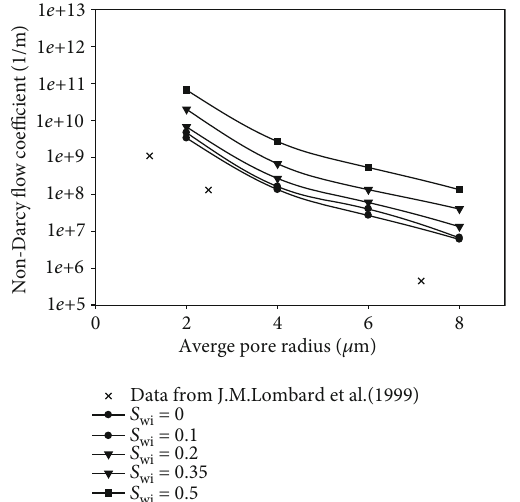
Figure 7: Curves of non-Darcy coe ffi cient and average pore radius at di ff erent irreducible water saturation.